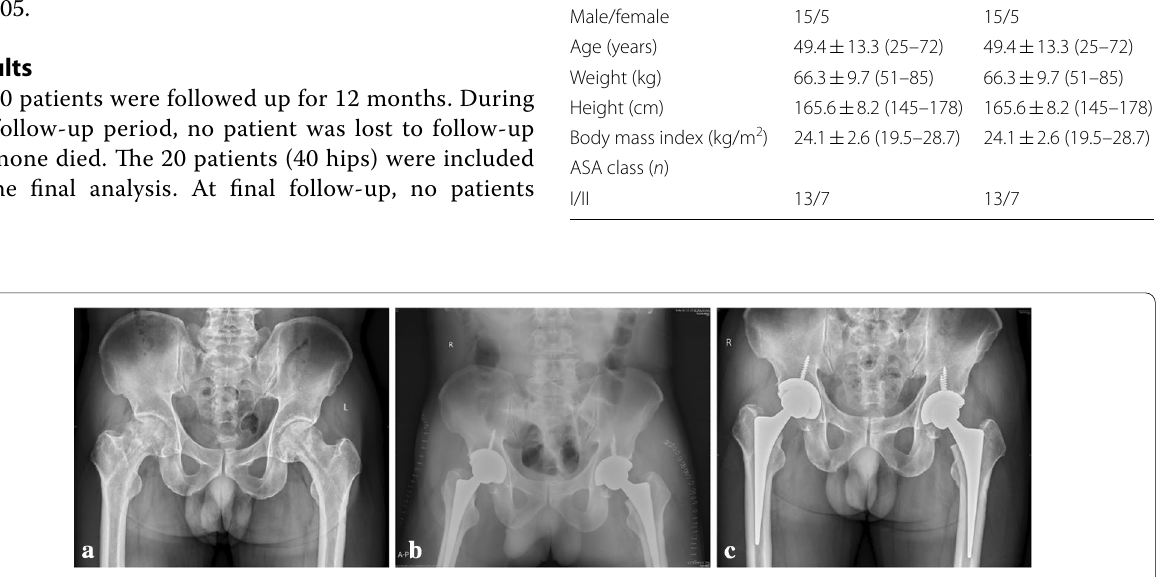
Fig. 1 a Preoperative anteroposterior (AP) hip radiograph of 49‑year‑old male patient with bilateral femoral head osteonecrosis; b X ‐ ray images 3 days postoperatively showing hip prosthesis in a good position (right: DAA‑THA; left: PLA‑THA); c AP hip radiograph at 12‑month follow‑up showing the prosthesis in a good position without loosening